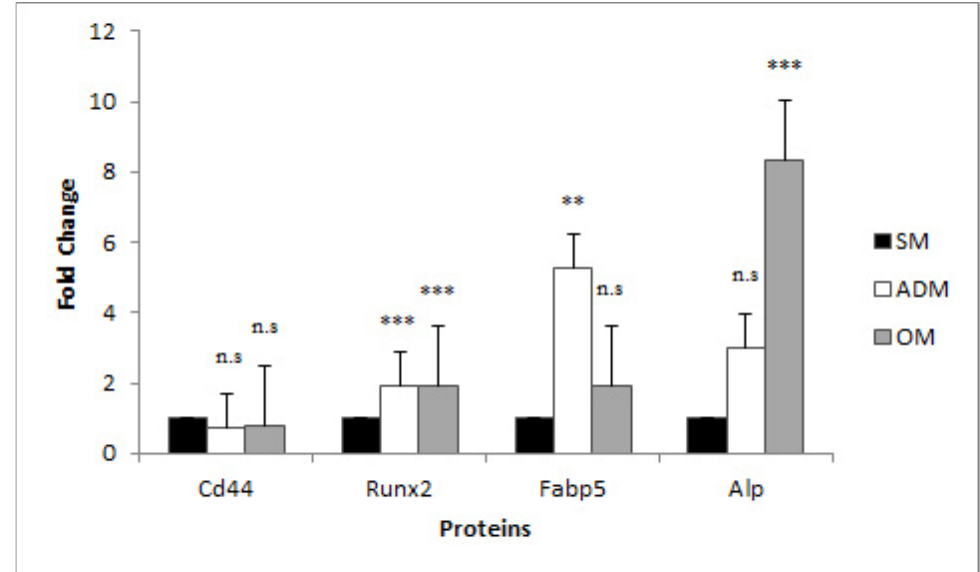
Figure 2. Relative expression of Cd44, Fabp5, Runx2, and Alp proteins in ADSCs submitted to SM, ADM, or OM conditions. ** = p < 0.01, *** = p < 0.001, n.s. = not significant.